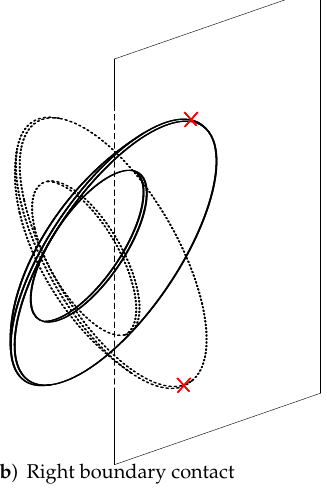
Figure 7. Boundary impact of deformed